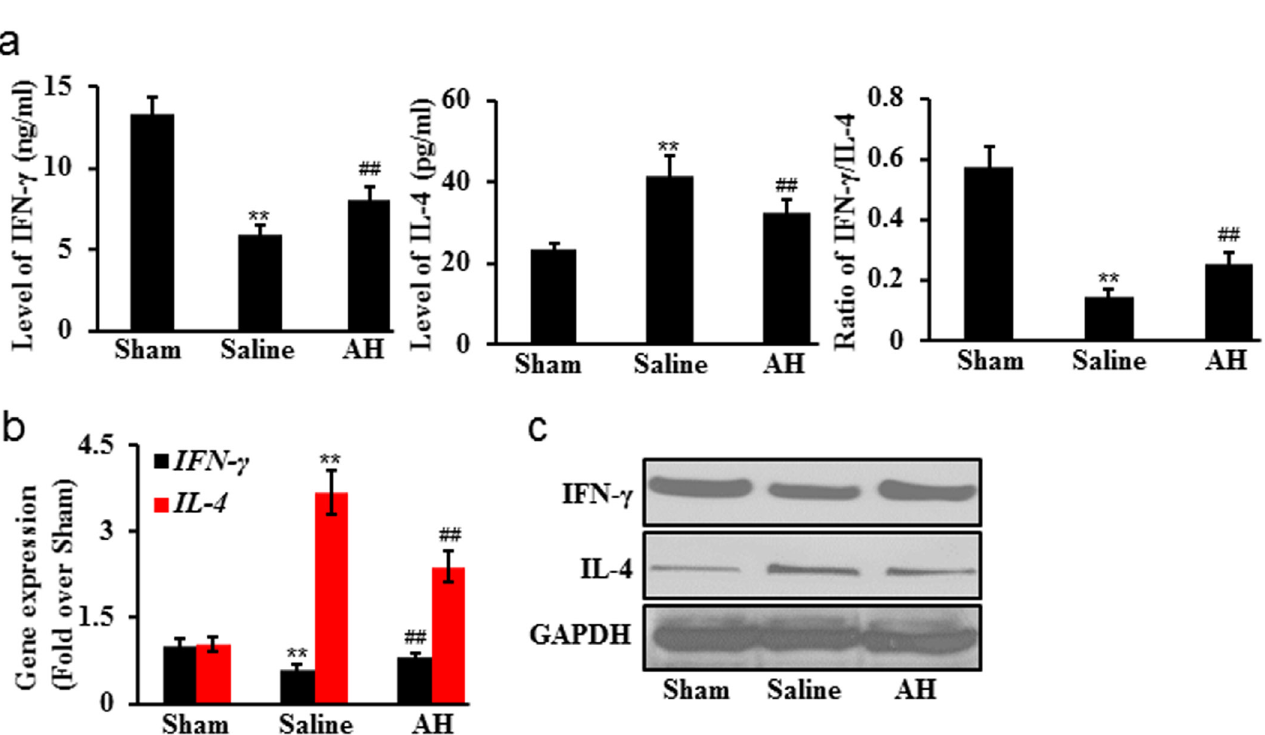
expression of IFN-γ, but decreased the gene and protein expression of IL-4 (b, c). Data were expressed as mean ± SD (n =